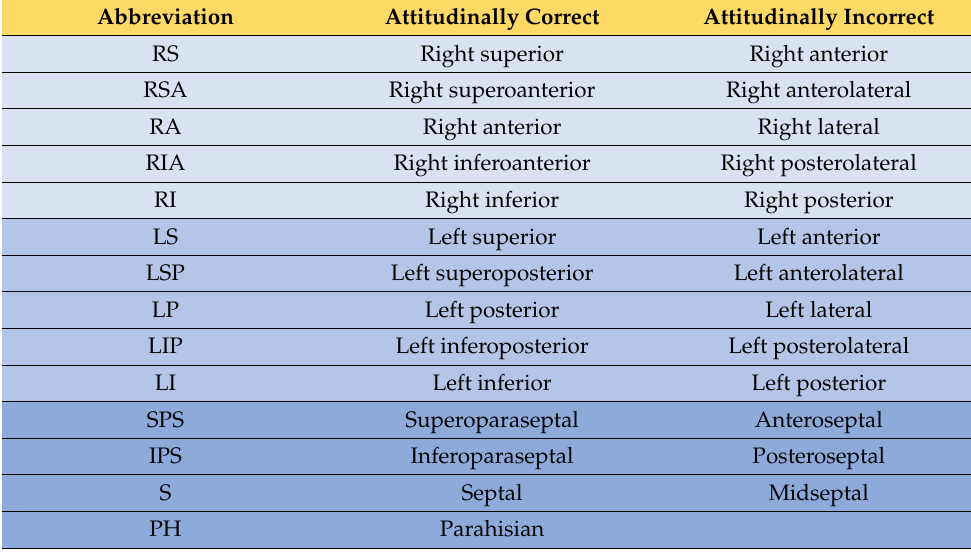
Table 2. Abbreviations used in this report to describe the different bypass tract locations.